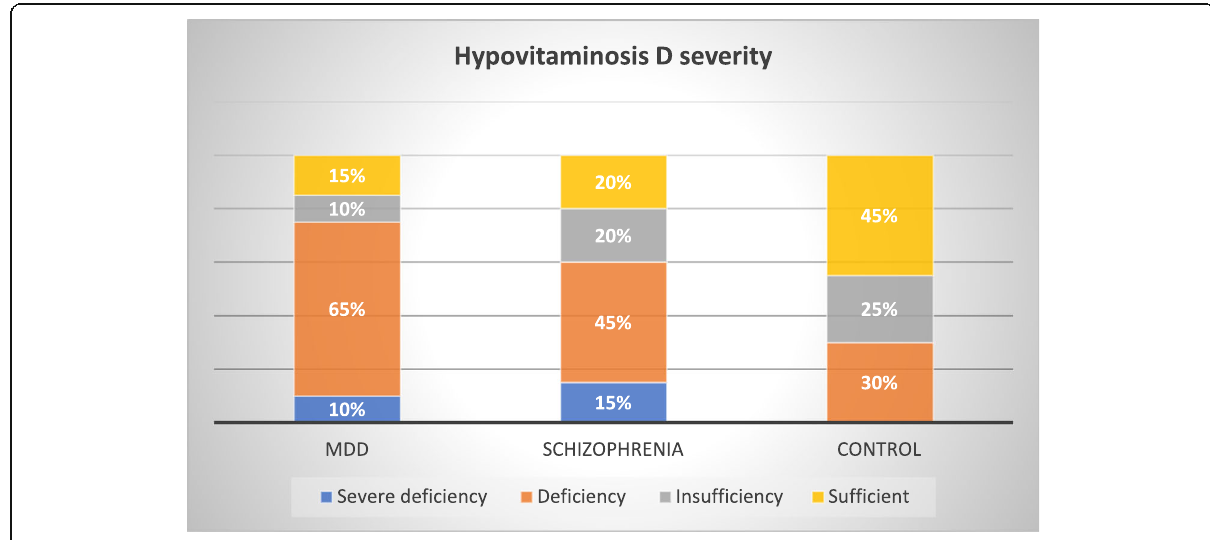
Fig. 1 Hypovitaminosis D severity among the study groups